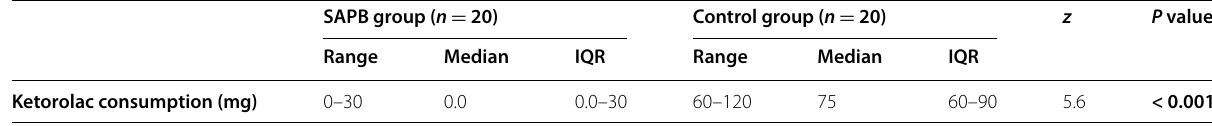
Data expressed as range, median; IQR Inter quartile range, z Mann-Whitney test, SAPB Serratus anterior plane block